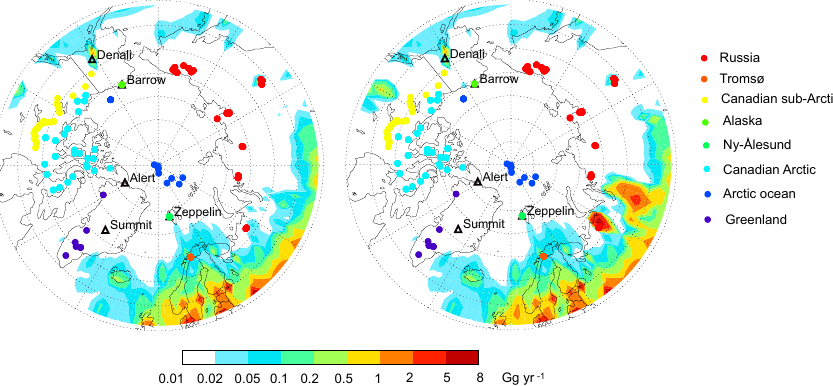
Figure 1. Annual BC emissions (Ggyr − 1 ) in the Arctic in experiment A (left panel) and experiments B, C, and D (right panel). Also shown are in situ BC measurement stations (open triangles) and snow sample locations (solid circles). The eight sub-regions of the Arctic as defined in Doherty et al. (2010) are color-coded. See text for